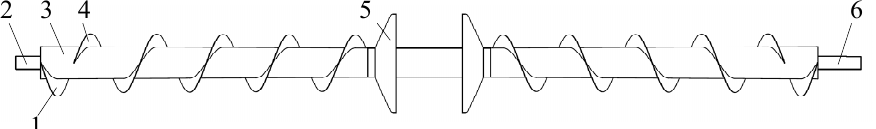
Figure 7. Structure diagram of soil leveling auger. ( 1 ) Reverse blade; ( 2 ) Power drive shaft; ( 3 ) Auger shaft; ( 4 ) Conveying blade; ( 5 ) Conical disc; ( 6 ) Chain drive shaft .